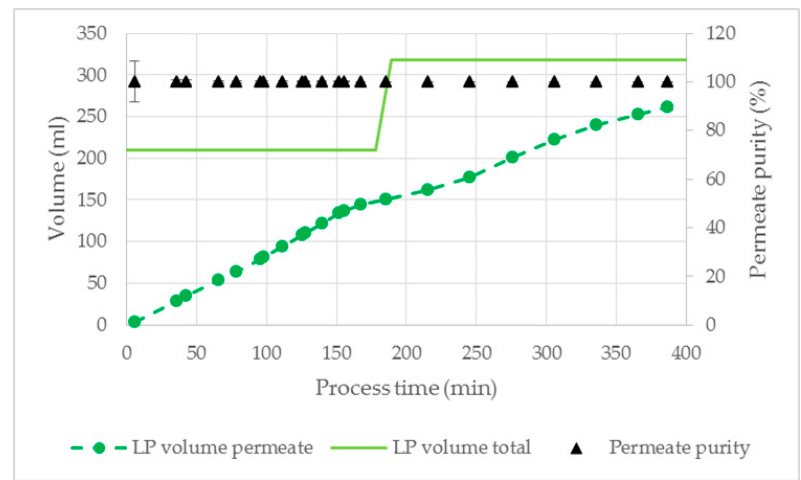
Figure 13. Volume of LP and permeate purity for the application study of the optimized ATPS with cultivation broth as the feed component. V = 400 mL, TMP = 100 mbar, dP = 250 mbar, Q = 16.7 mL/min. LP: light phase.